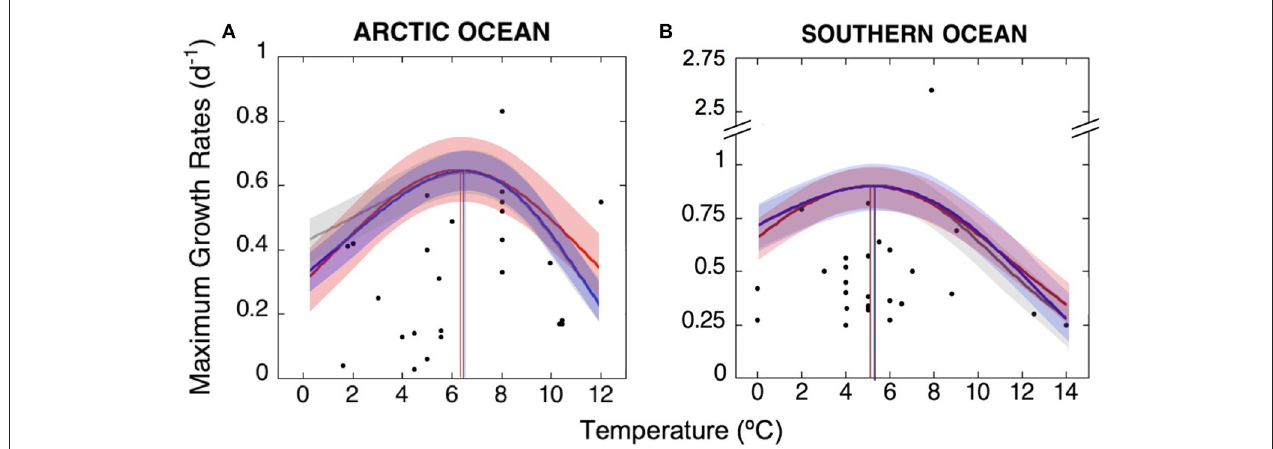
FIGURE 4 | T OPT for growth of Arctic and Antarctic phytoplankton communities. Maximum growth rates observed at the T OPT of phytoplankton species and communities inhabiting (A) the Arctic and (B) the Southern Ocean, obtained from the literature and new experimental data. We used three fits to better predict T OPT for the whole phytoplankton communities in each polar ocean: gray lines represent the best fit of the Johnson and Lewin model as described by Dell et al. (2011); red and blue curves represent the Gaussian and Weibull functions, respectively, as described by Angilletta (2006). The T OPT calculated by each model were similar and are marked here by vertical lines corresponding to the three fits, which averaged 6.5 ± 0.2 ◦ C for the Arctic and 5.2 ± 0.1 ◦ C for the Antarctic communities. Shaded areas represent the sum of squared errors ( ± SSE) of each thermal performance curve.